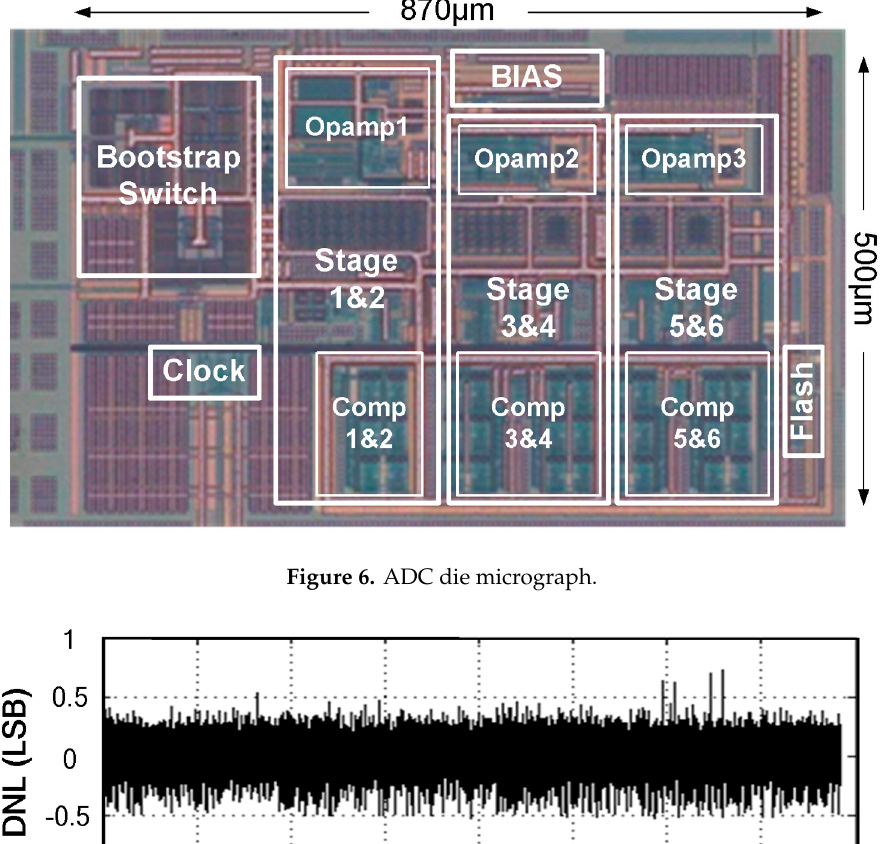
Figure 6. ADC die micrograph.